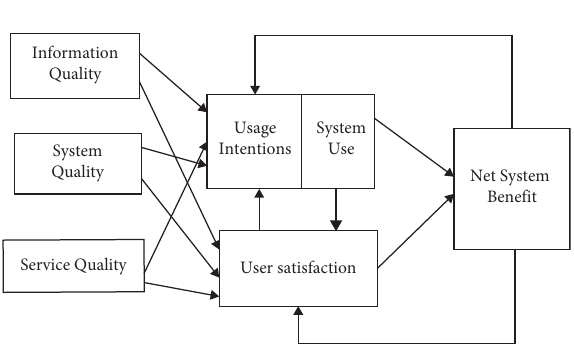
Figure 1: Source: DeLone and McLean